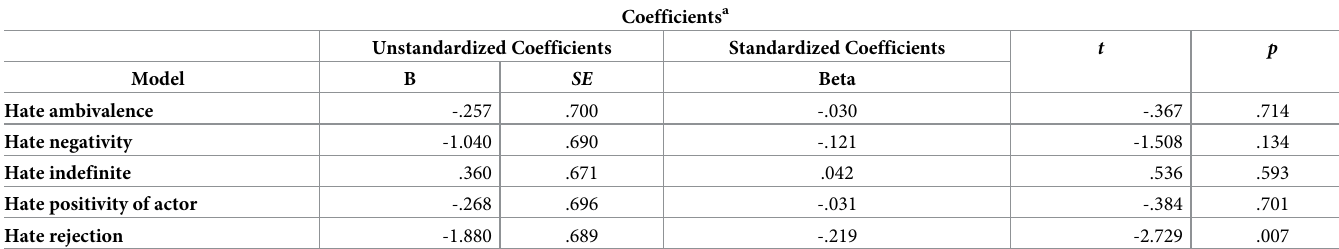
Table 9. Hate script: Multiple regression analysis; script’ factors predict trait anxiety.